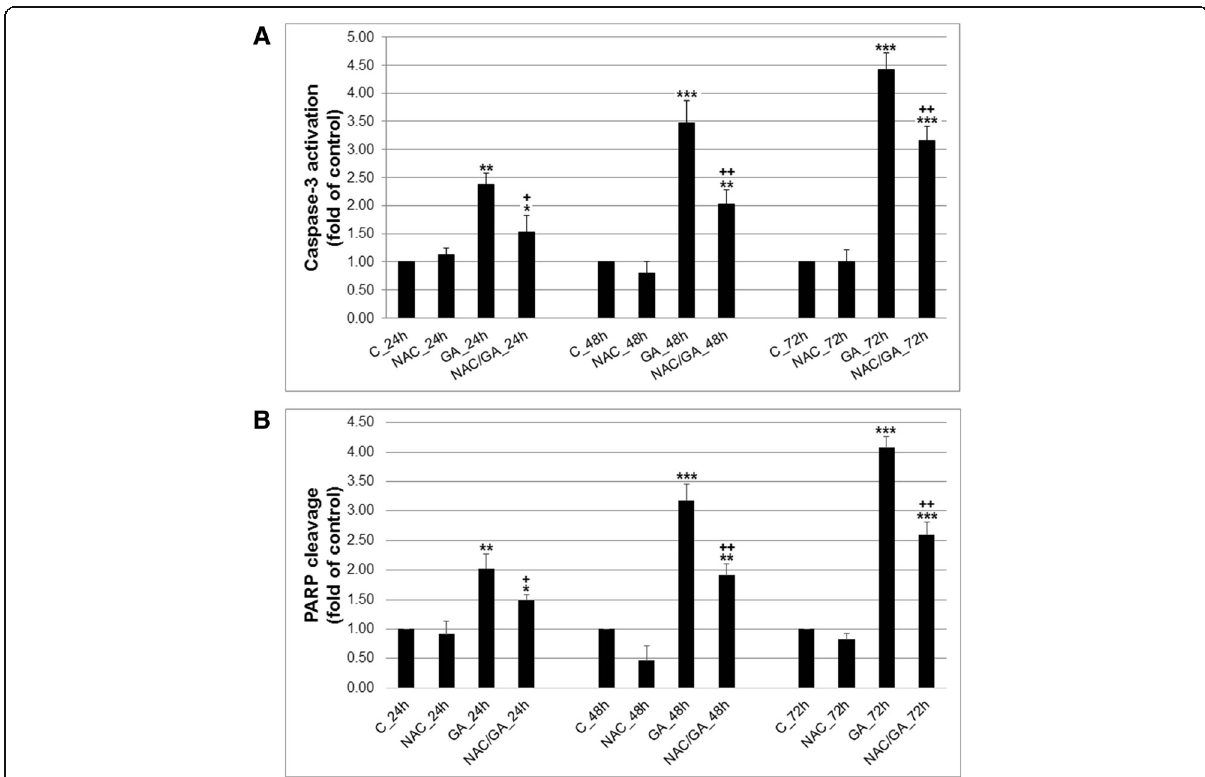
Fig. 3 a Effect of GA alone or after NAC pre-treatment on caspase-3 activity. b Effect of GA alone or after NAC pre-treatment on PARP cleavage. Data represents mean ± SD from 3 independent experiments. Significance: * P < 0.05, ** P < 0.01, *** P < 0.001 versus untreated cells (control); + P < 0.05, ++ P < 0.01, versus